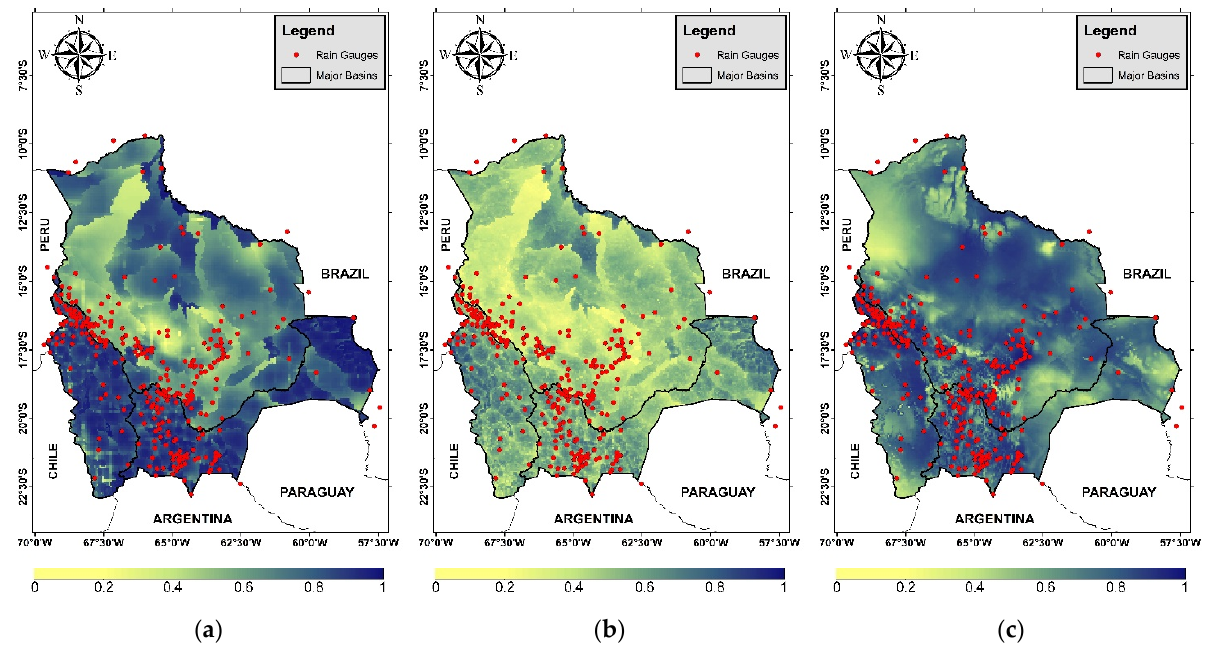
Figure 12. Daily correlation coefficient map: ( a ) GS, ( b ) CH and ( c ) GMET.